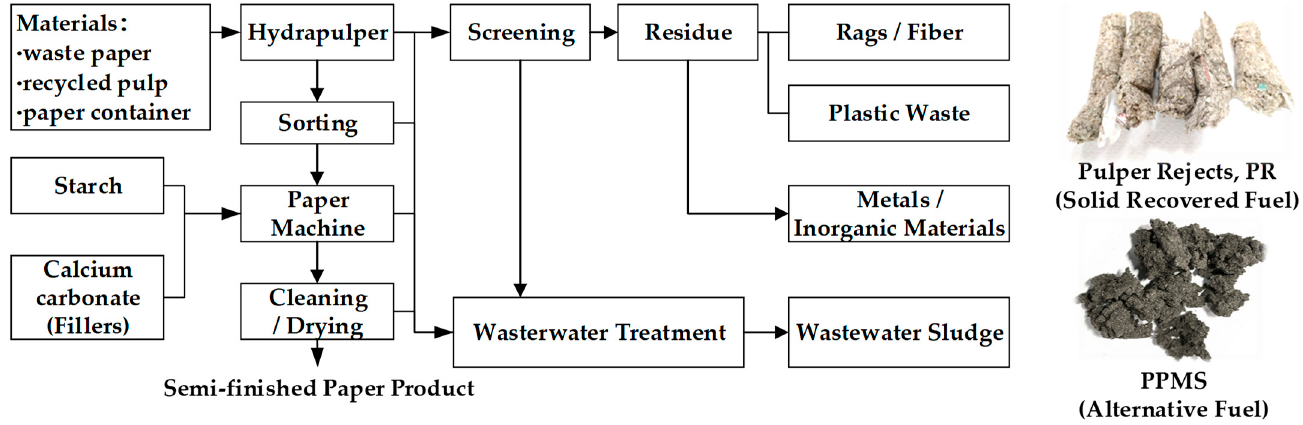
Figure 1. Waste-derived fuel generated during papermaking in a paper recycling